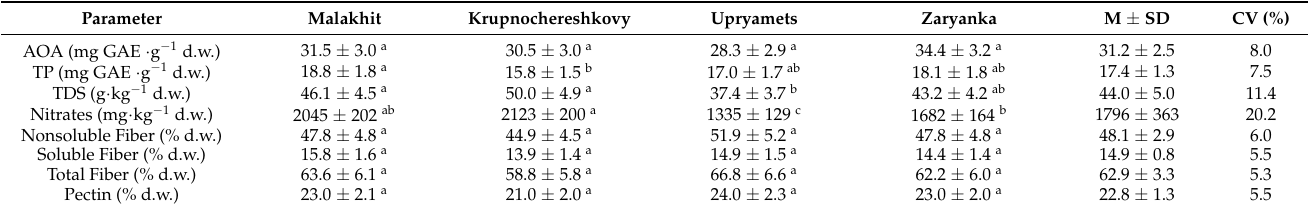
Table 4. Biochemical characteristics of stalk